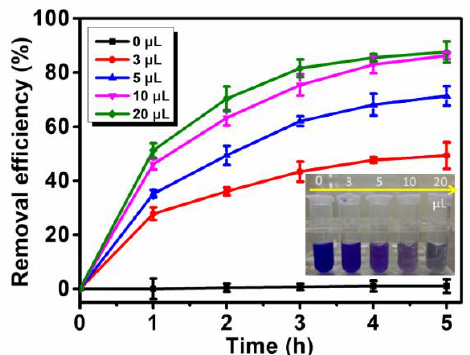
Figure 6. The relationship between the amounts of ABTS (15 mM) added into the system and the dye removal efficiency as well as the inserted photo of crystal violet (CV) (50 mg/L) after removal by free Lac at 40 °C for 5 h.